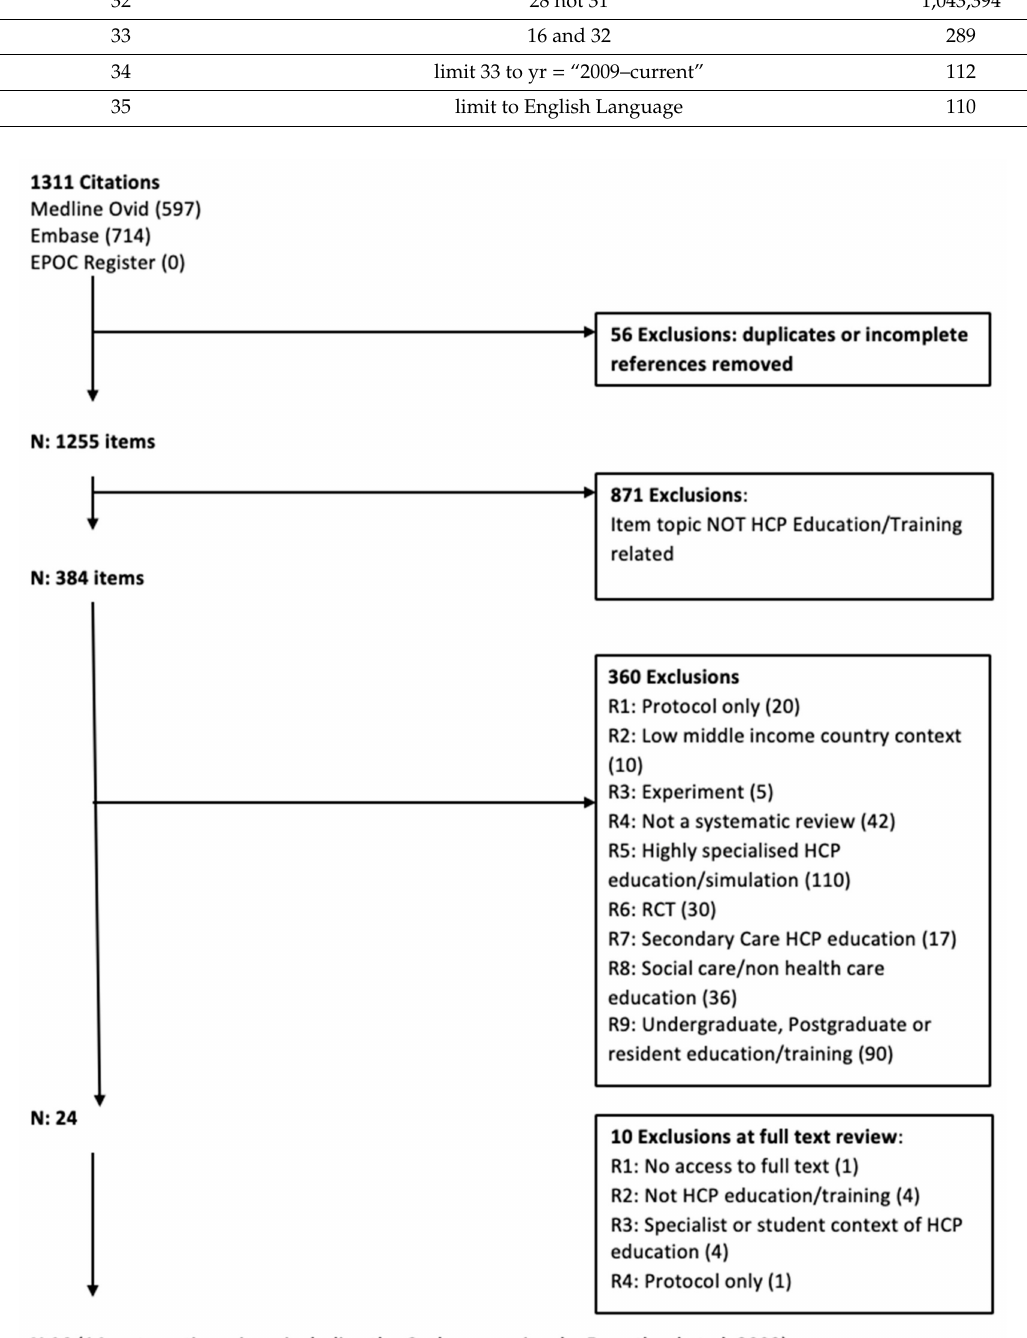
Figure A1. Flow chart for the rapid review of health professional training shown to improve clinical